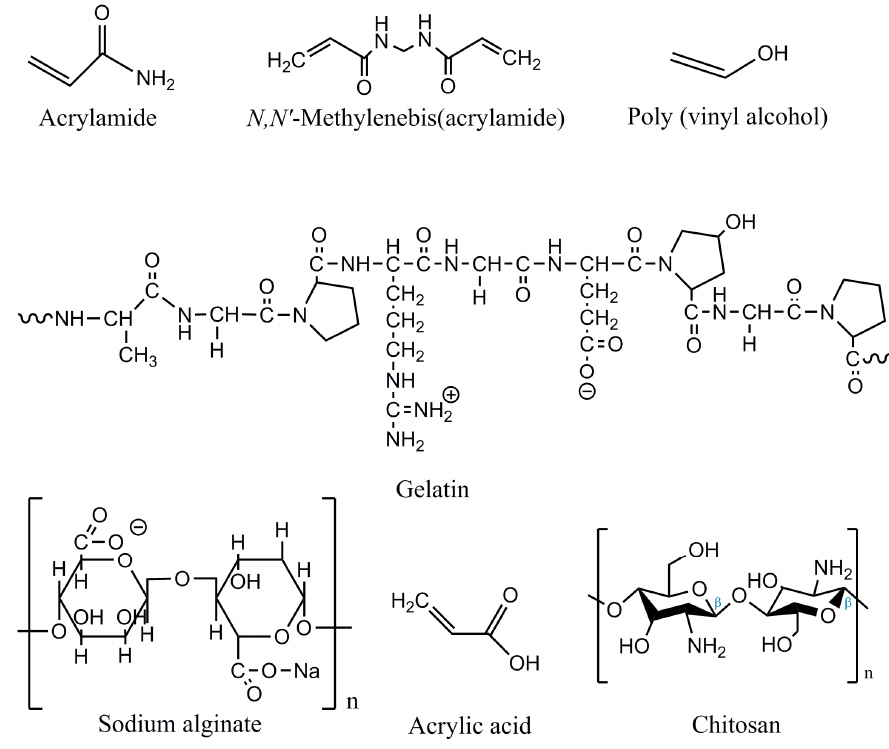
Figure 1. Chemical structure of some of the compounds that enable cross-linking with gelatin for the synthesis of gelatin-based hydrogels.